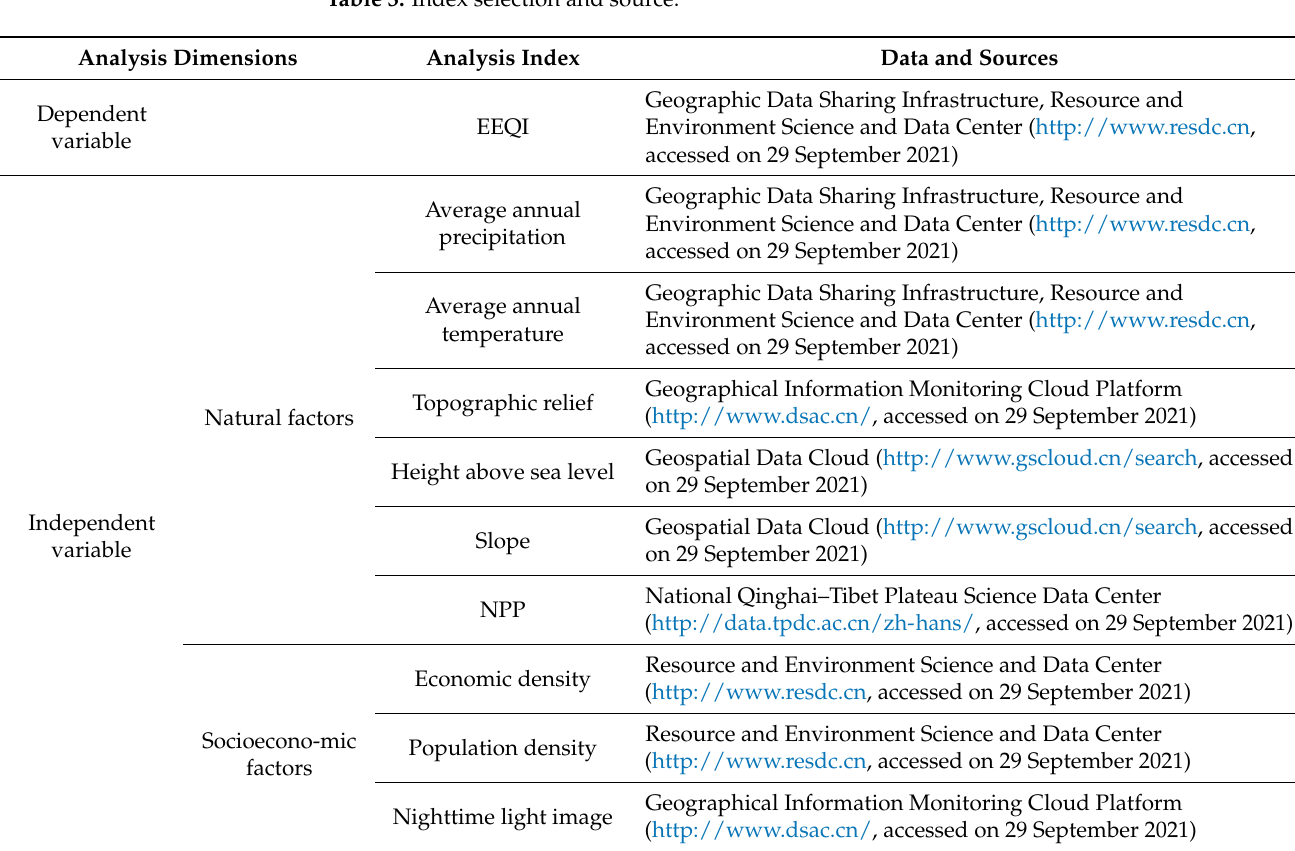
Table 3. Index selection and source.